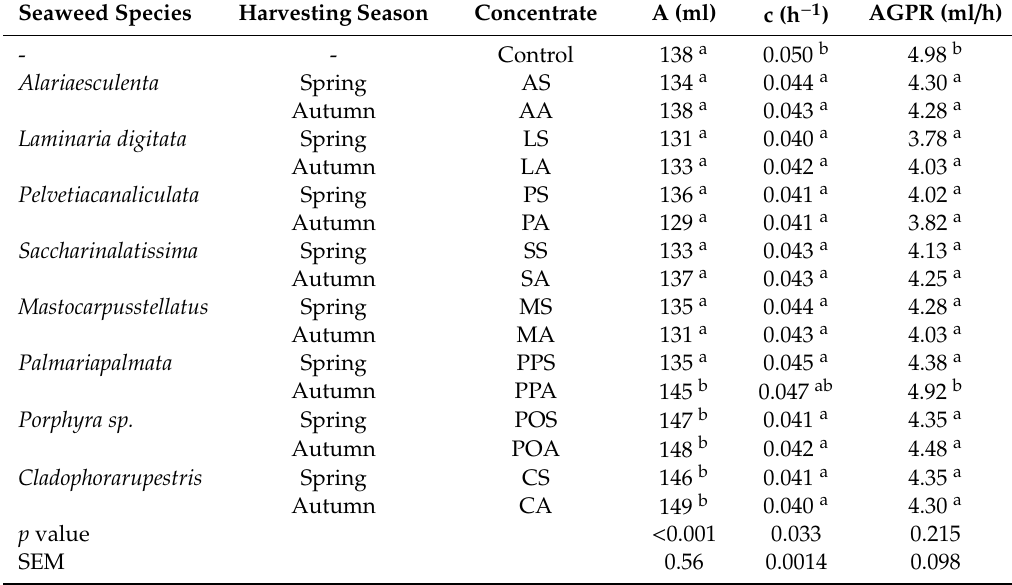
a-b For each parameter, the mean values for each diet not sharing the same superscript di ff er ( p < 0.05). 1 A: asymptotic gas production; c: rate of gas production; AGPR: average gas production rate. The values of lag were 0 for all samples. Data are expressed per 0.5 g DM